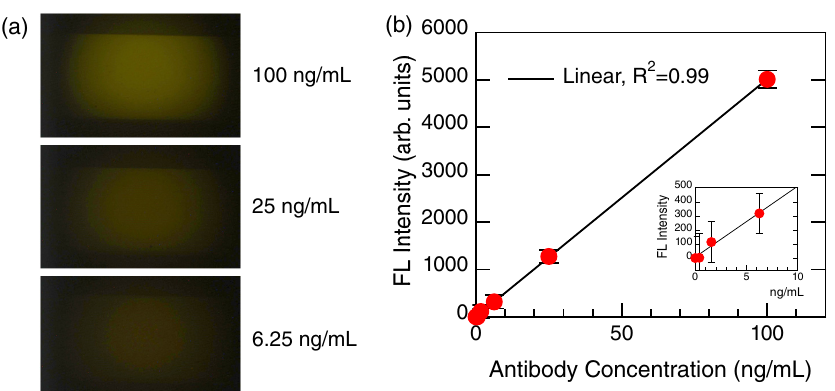
Figure 5. Detection of Abs, as illustrated in Figure 1b. ( a ) FL images (raw color) at different Ab concentrations from 100 to 6.25 ng/mL (or 686 to 41.2 pM). ( b ) Linear plot of the FL intensity for the Ab concentrations. The measured data are shown with red closed circles with error bars. The black line is linearly fitted. The inset magnifies a low-concentration range.